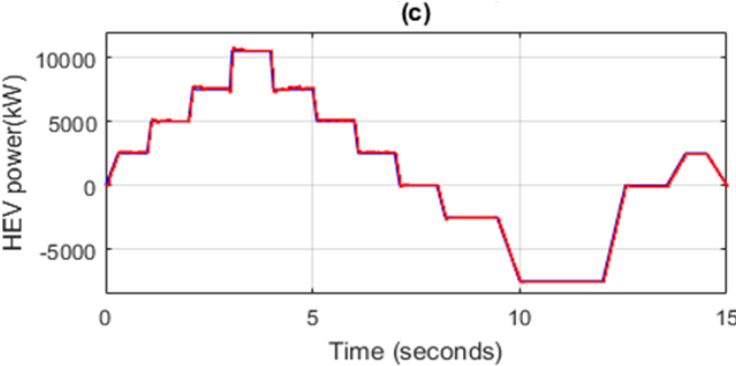
Figure 14. HEV power using different transition techniques. ( a ) Classical abrupt switching ( b ) SBT switching ( c ) LBT switching.